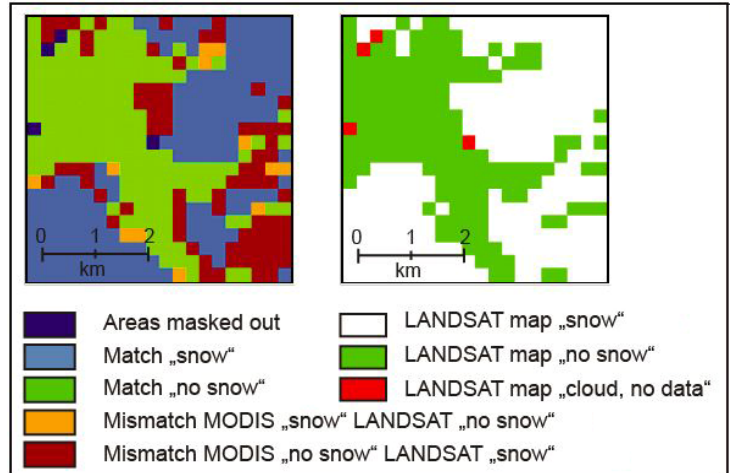
Figure 2. Example of snow cover maps (SCA) map comparison result. Left: map showing the areas of match and mismatch between Landsat and EURAC SCA maps. Right: Landsat snow map of the same